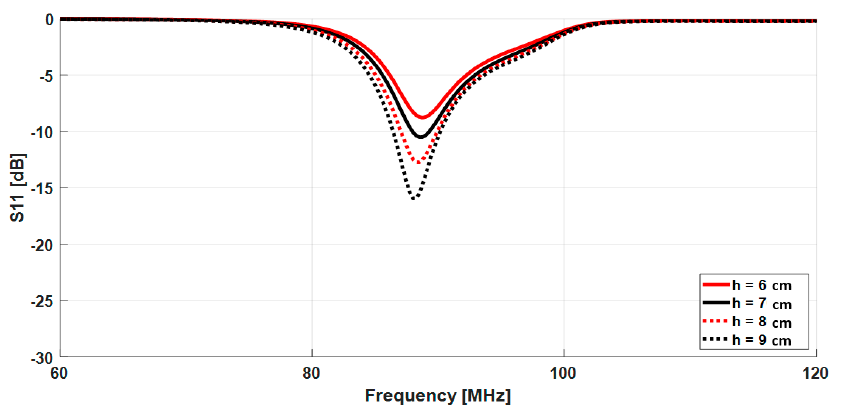
Figure 6. Parametric study on the reflection coefficient (S11) by varying the air substrate height ( h ).